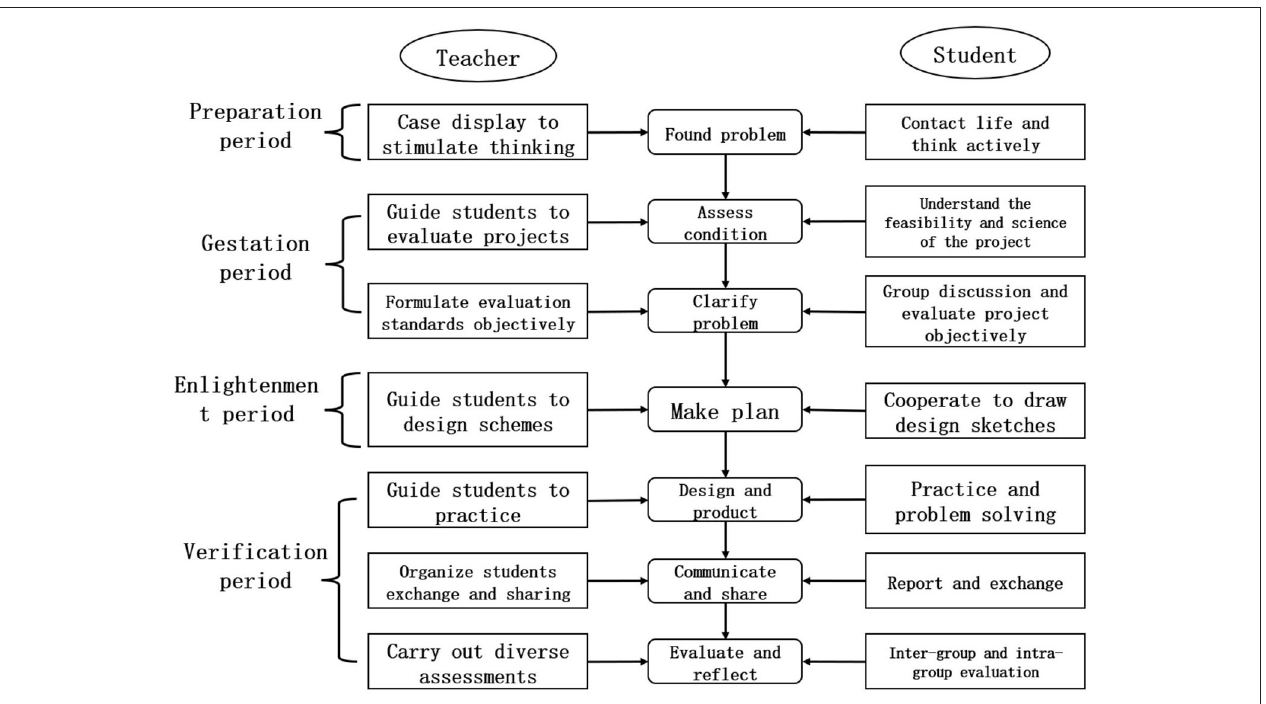
FIGURE 1 | General Technology Course teaching model based on the concept of maker education (original).